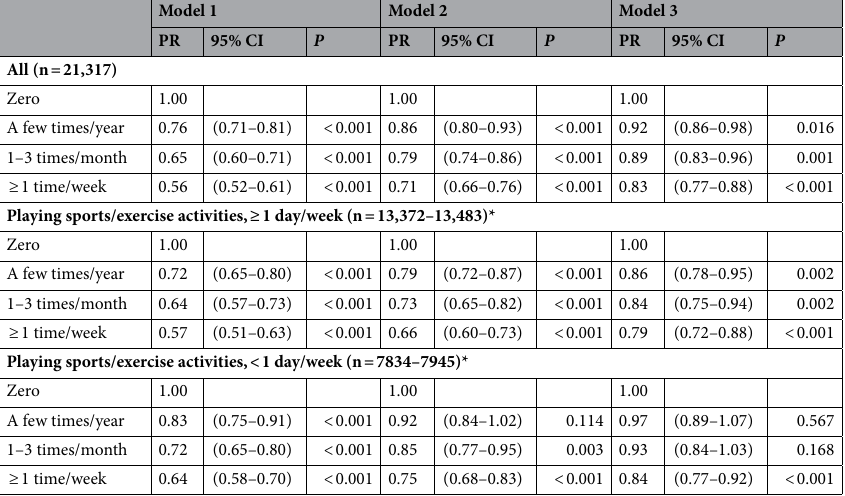
between watching sports and depressive symptoms in the whole-sample analysis. The proportion explained by the mediating effect was 9.6%–23.7%.